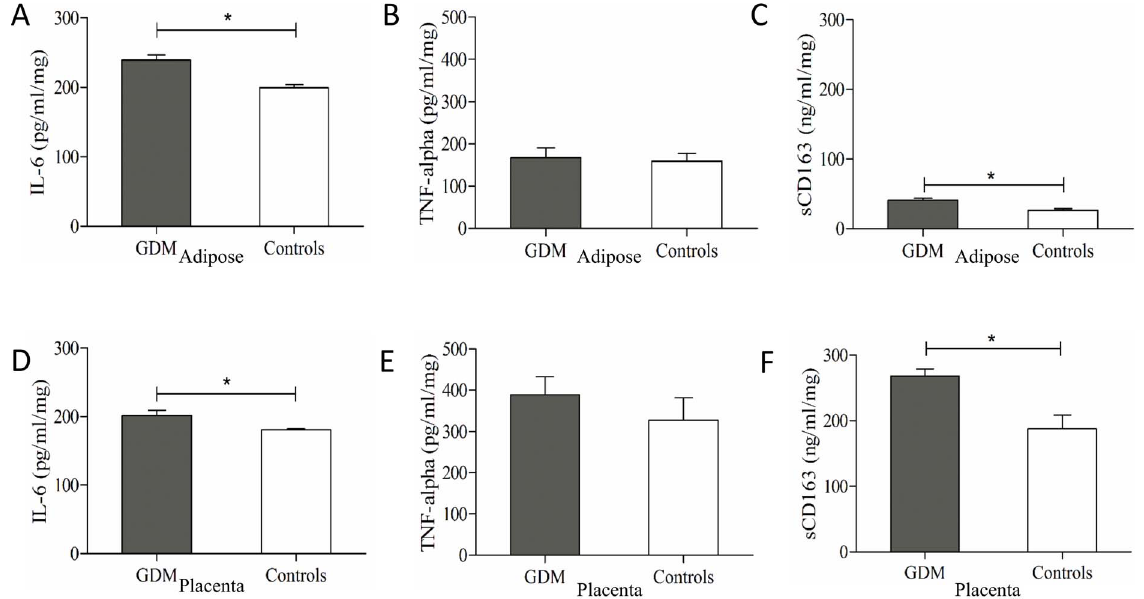
Figure 3. Immunohistochemistry and cell count of CD163 positive cells in GDM (A and B) and controls (C and D) of placental (A and C) and adipose tissues (B and D). CD163 positive cells, in ten random areas at 40 6 magnification for placenta and adipose tissues respectively were counted and analysed using image J. Mean with SEM of CD163 positive cell in placenta (E) and adipose tissues (F) [*p , 0.05, **p , 0.001].